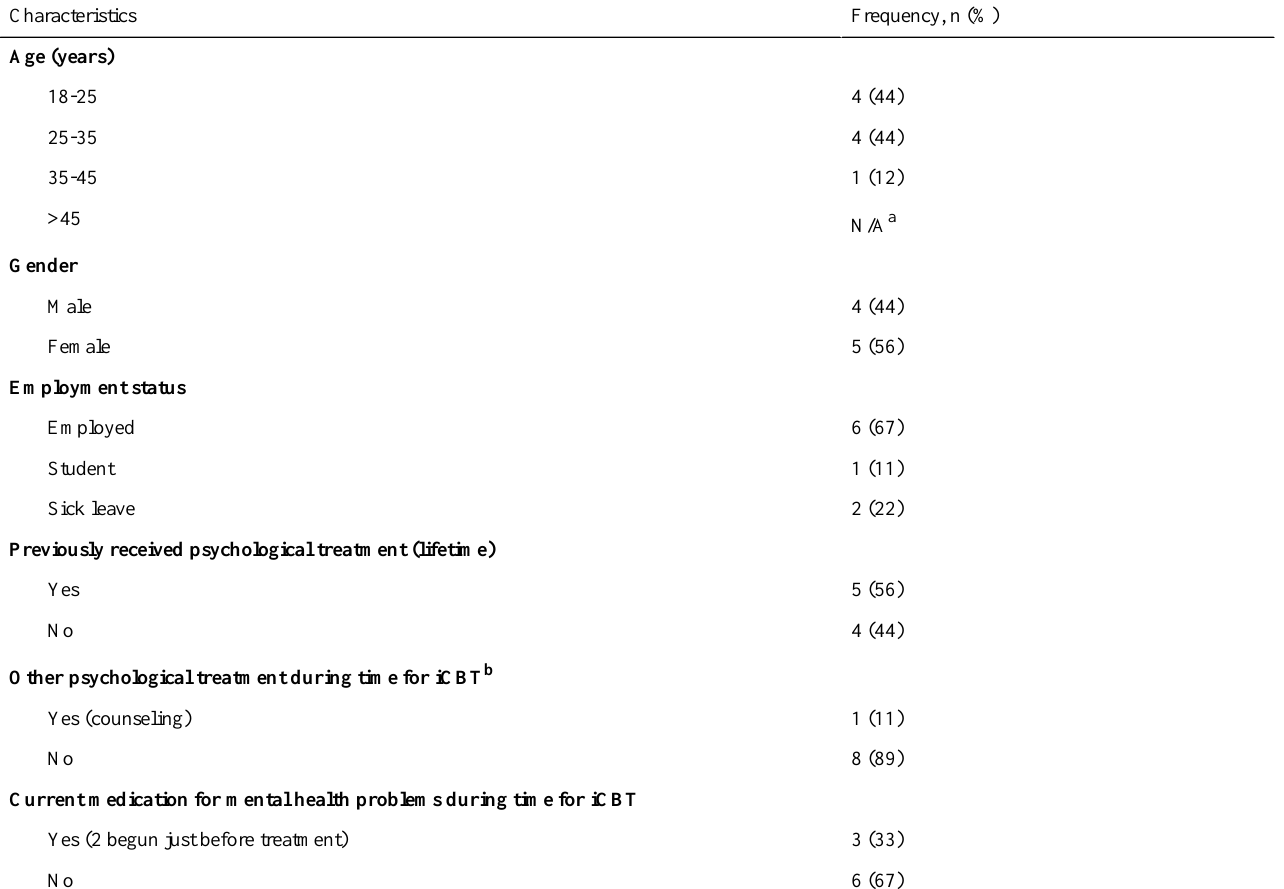
Table 1. Demographic variables of patients (n=9) participating in the